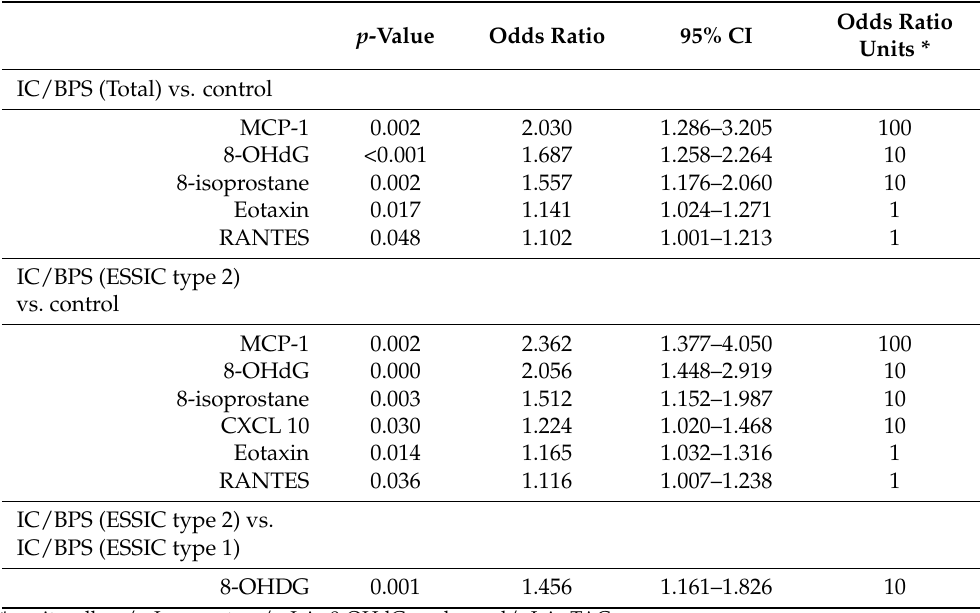
Odds Ratio Units *